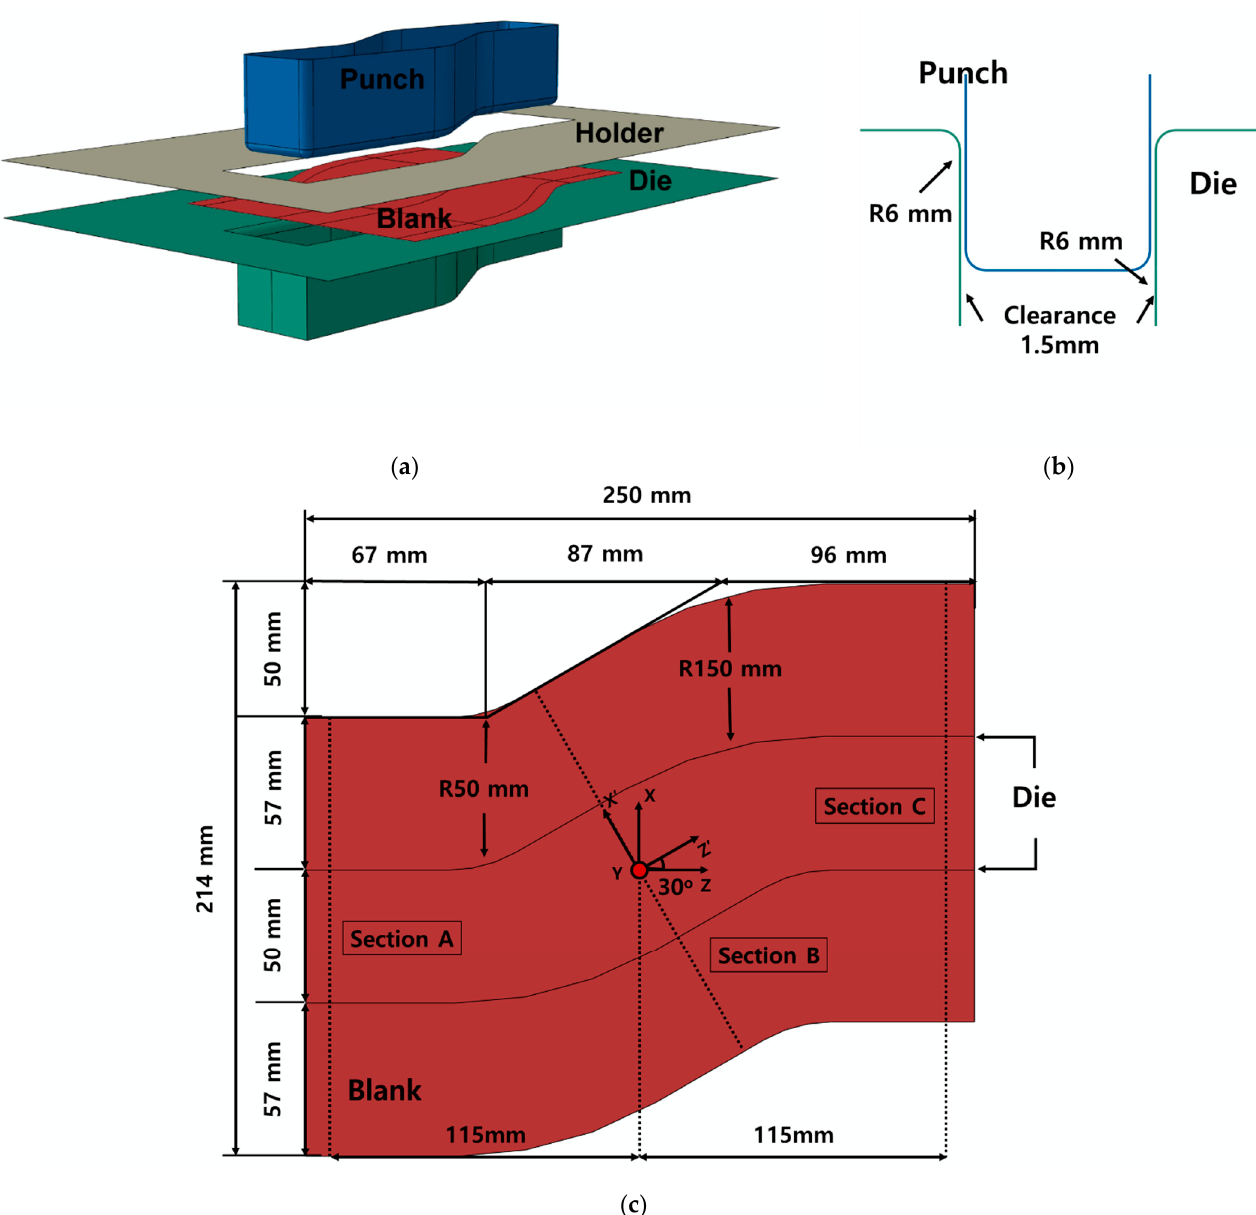
Figure 13. ( a ) Schematic view of FE model set-up for S-rail forming simulation, ( b , c ) dimensions of the tools and blank, respectively.